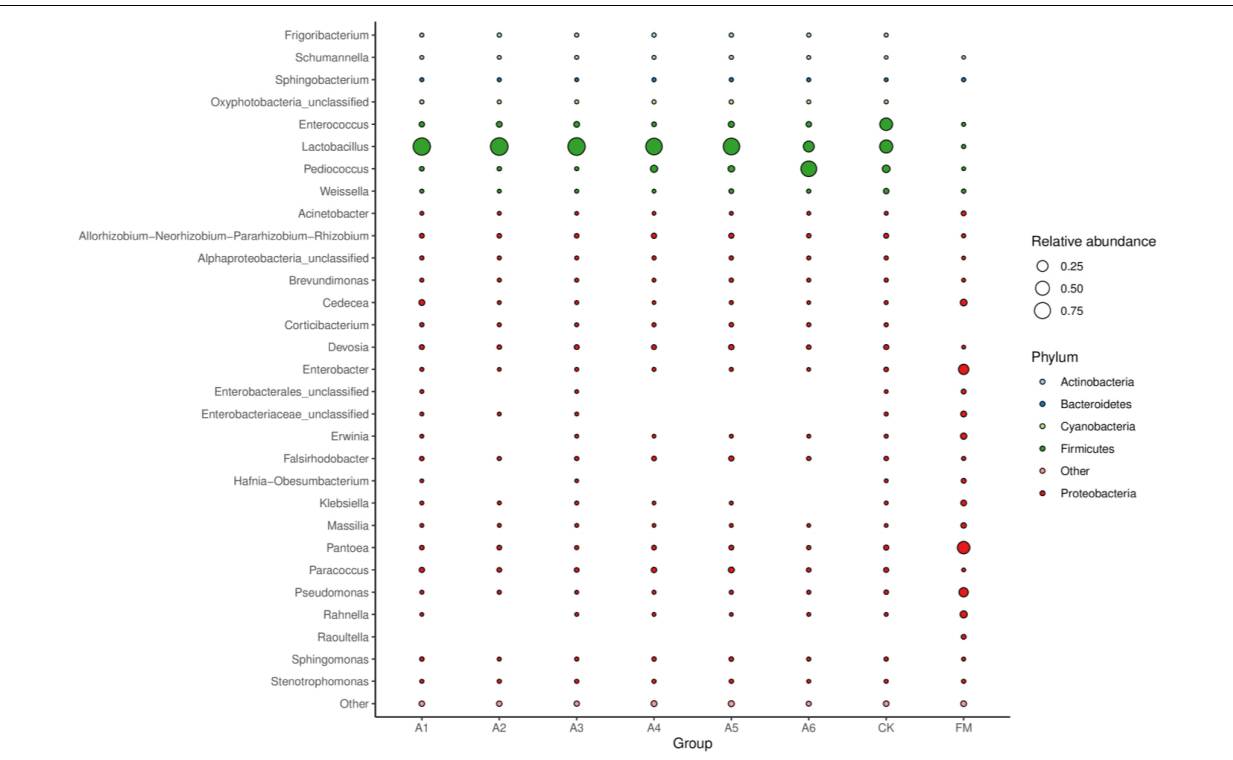
FIGURE 3 | Bubble plot of the bacterial community (genus level) among silages and fresh material ( n = 4, p < 0.05). FM, fresh materials; CK (Control), 2.00 ml/kg fresh weight (FW) of distilled water; A1, 2 g/t FW of the first additive and 2.00 ml/kg FW of distilled water; A2, 2 g/t FW of the second additive and 2.00 ml/kg FW of distilled water; A3, 5 g/t FW of the third additive and 2.00 ml/kg FW of distilled water; A4, 1 g/t FW of the fourth additive and 2.00 ml/kg FW of distilled water; A5, 1 g/t FW of the fifth additive and 2.00 ml/kg FW of distilled water; A6, 1 g/t FW of the sixth additive and 2.00 ml/kg FW of distilled